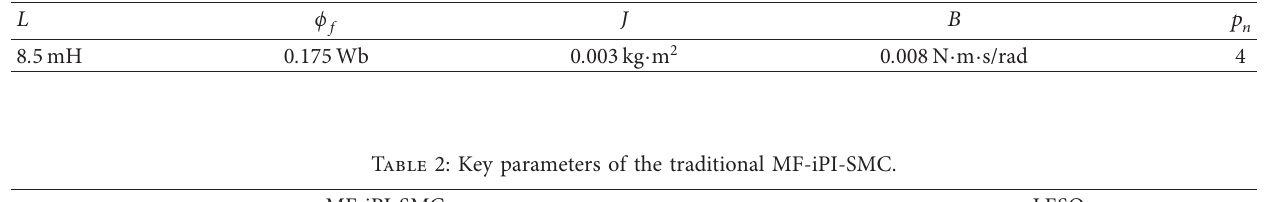
Table 1: Parameters of the PMSM.